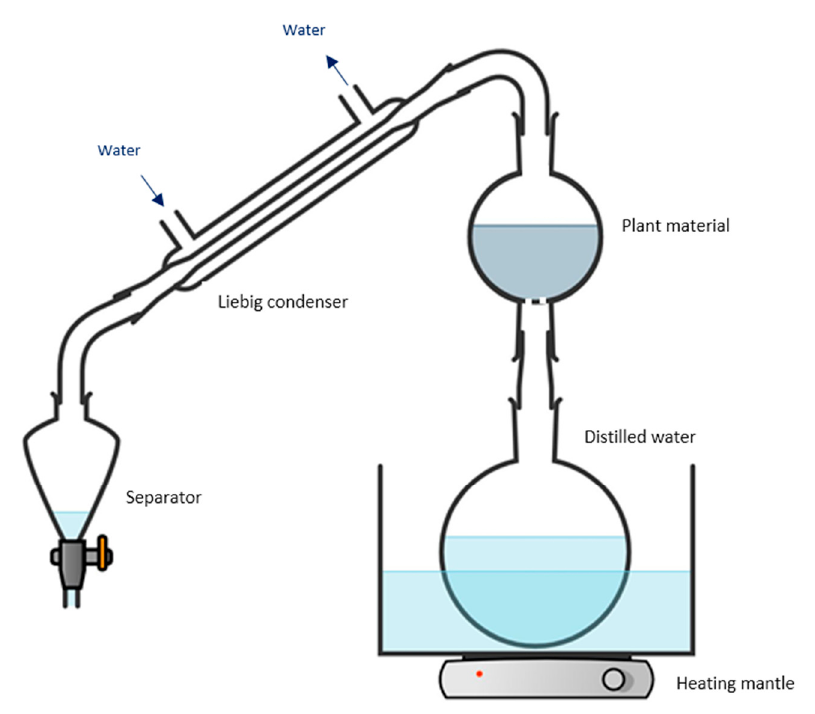
Figure 4. Schematic diagram of the steam distillation set-up. (Figure created by the authors: https://chemix.org/ (accessed on 10 October 2020)).